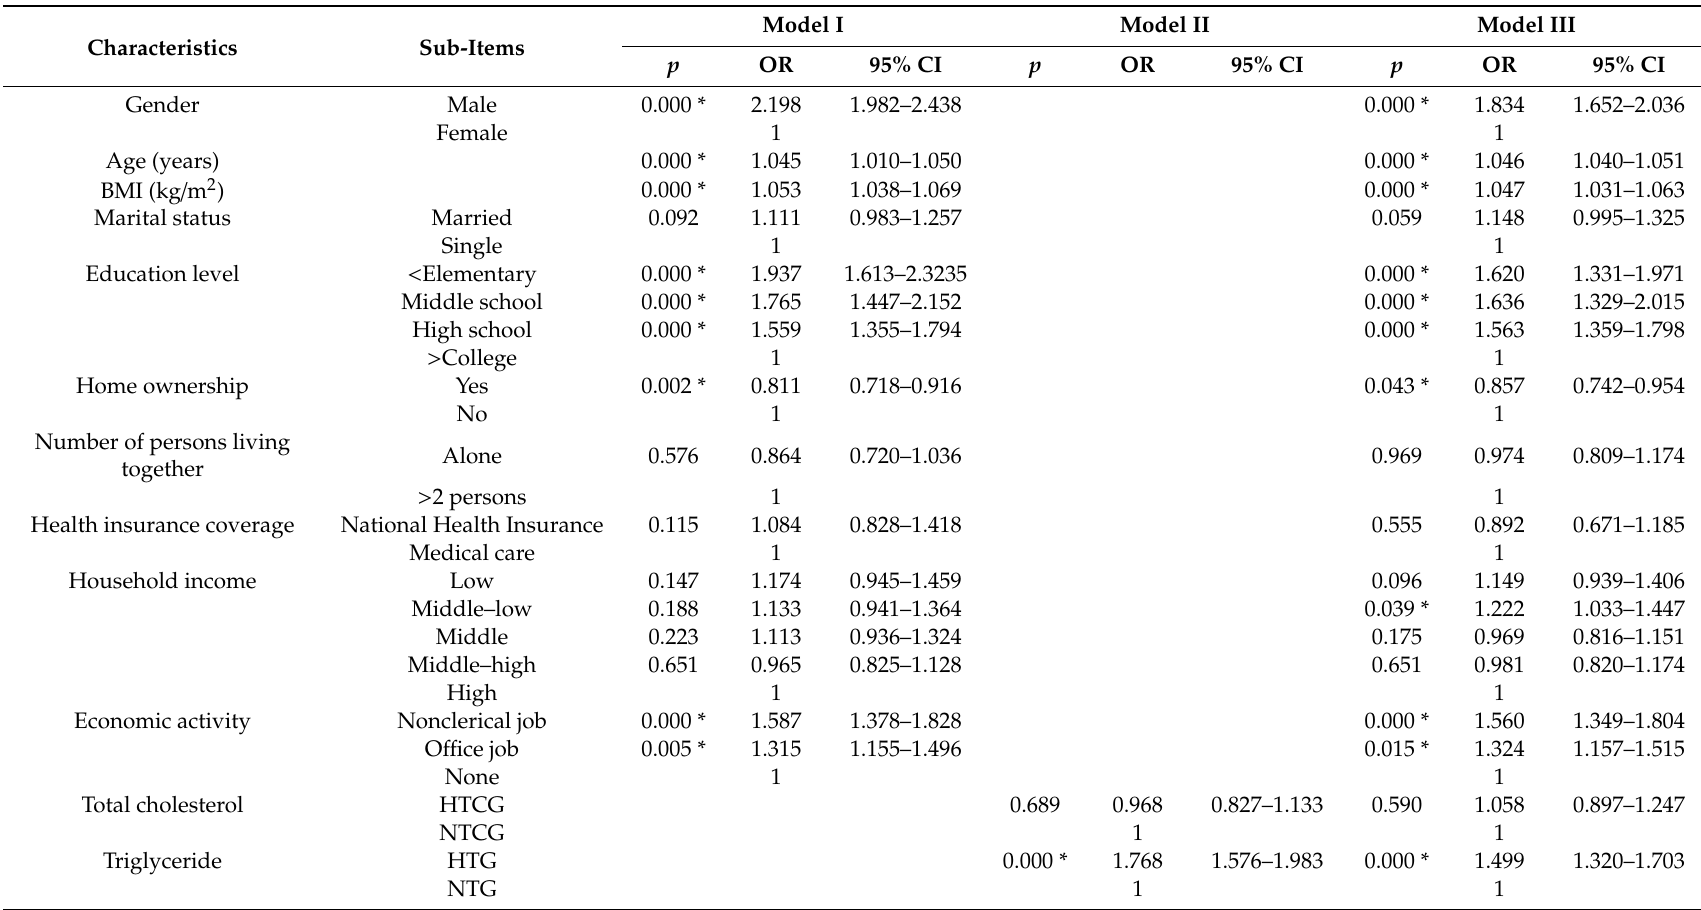
Table 5. The odds ratios and 95% confidence intervals of demographic characteristics and blood lipid levels with respect to the prevalence of periodontal disease.